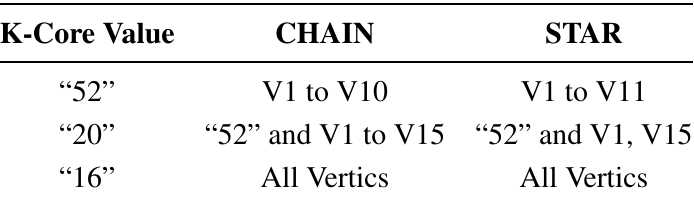
Table 3. The three k-core values and the vertices composing them for each connection topology, CHAIN and STAR, for the 19 files from Table 1. The k-core values represent the minimum bytes shared between any vertices belonging to the core.